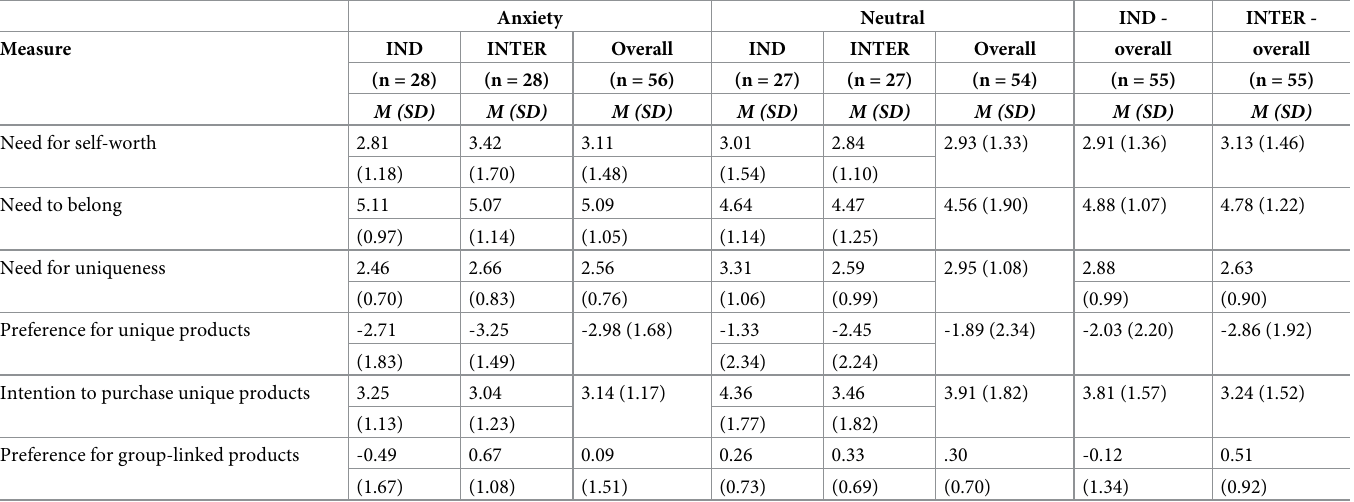
Table 2. Descriptive statistics for self-reports in Study 1.